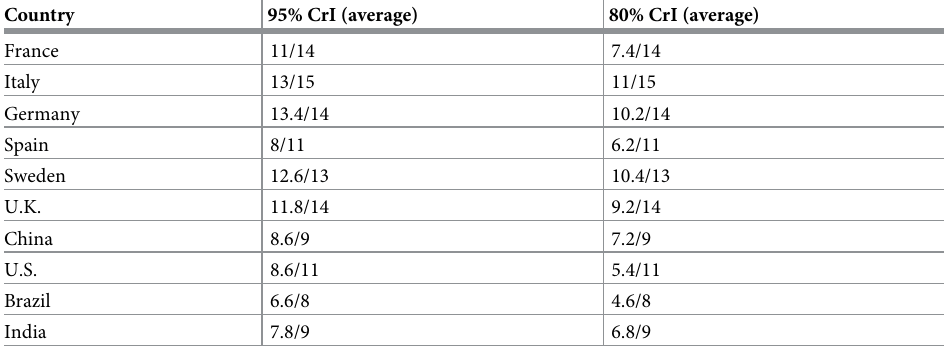
Table 4. Number of missing data points with actual value within 95% and 80% CrIs, out of the total number of missing data points.